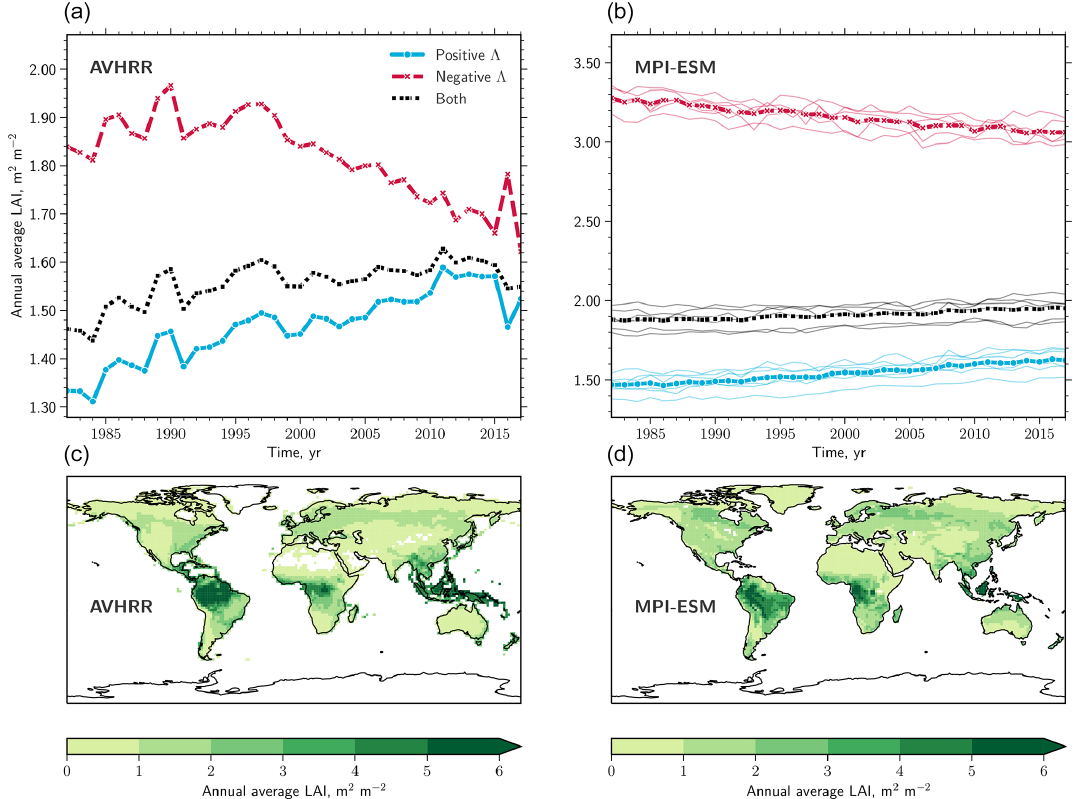
Figure 1. LAI observations versus MPI-ESM ensemble. (a) Time series of area-weighted annual average LAI for regions exhibiting positive (blue line) and negative trends (red line) masked for natural vegetation (denoted (cid:51) ). Black lines represent the overall signal of all pixels. (b) As (a) but for the MPI-ESM. The individual realizations are represented as thin lines, and the ensemble means are shown in bold lines. (c) Global patterns of annual average LAI over the time period 1982–2017 downscaled to the MPI-ESM spatial resolution using first-order conservative remapping scheme (Jones, 1999). (d) As in (c) but for the